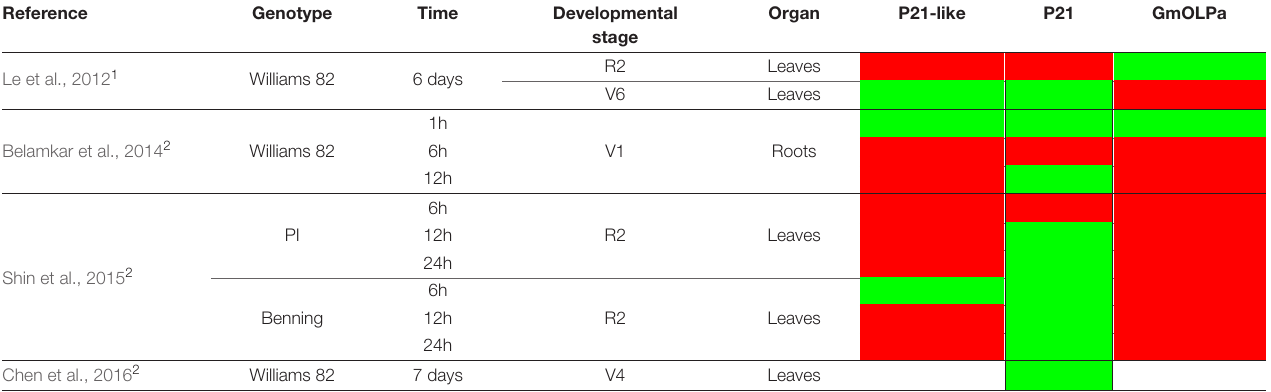
FIGURE 5 | In silico gene expression analysis. (A) Relative expression profile of soybean osmotin genes from the RNA-seq BAR database (http://bar.utoronto.ca/efpsoybean/cgi-bin/efpWeb.cgi) (Libault et al., 2010). Red and blue colours indicate upregulated and downregulated genes, respectively (Log 2 ratio) in different organs/tissues as plotted in the bar scale. (B) Digital gene expression counts of the uniquely mappable reads from RNA-Seq Atlas of Glycine max raw data (Severin et al., 2010). RNA-seq reads were only mapped to the initial genome assembly (i.e., Wm82.a1.v1). TABLE 3 | Microarray and RNA-seq data from soybean submitted to drought stress experiments.